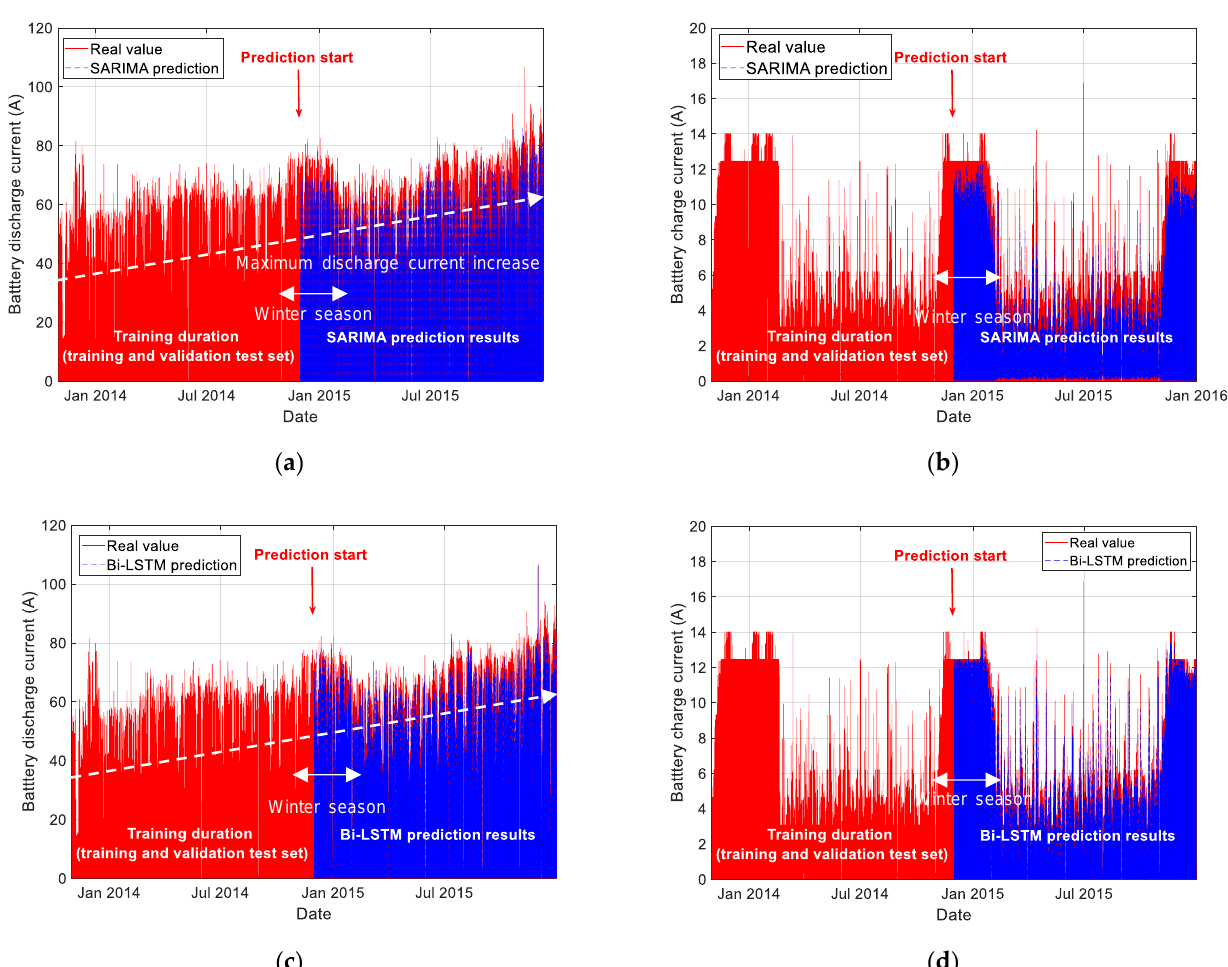
Figure 10. KOMPSAT-5 battery charge and discharge current prediction results: ( a ) SARIMA results for discharge current; ( b ) SARIMA results for charge current; ( c ) Bi-LSTM results for discharge current; ( d ) Bi-LSTM results for charge current.